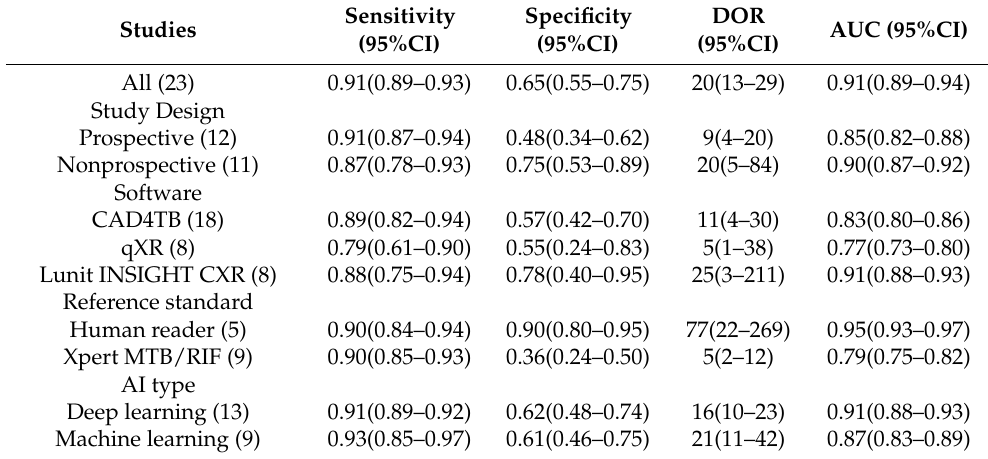
Table 2. Subgroup analysis based on different standards.